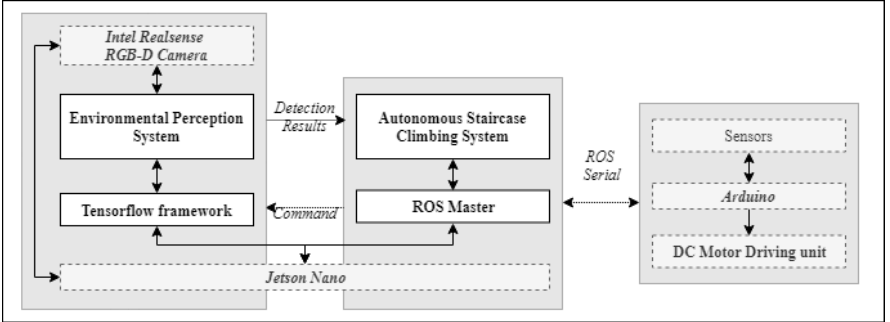
Figure 3. Hardware